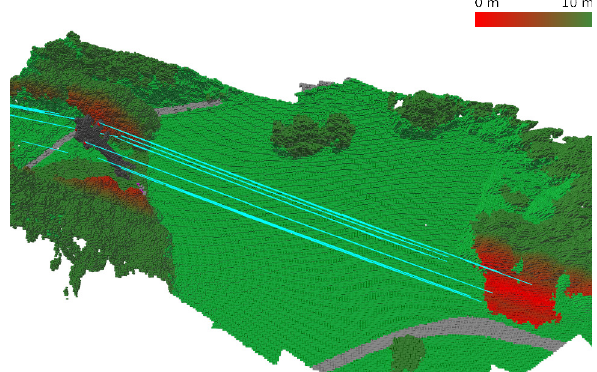
Figure 12. Color coded 3D result of Set1: The objects are color coded by their semantics according to Table 3. In addition the distance of trees to power line is color coded from red to dark green and truncated at a distance of 10